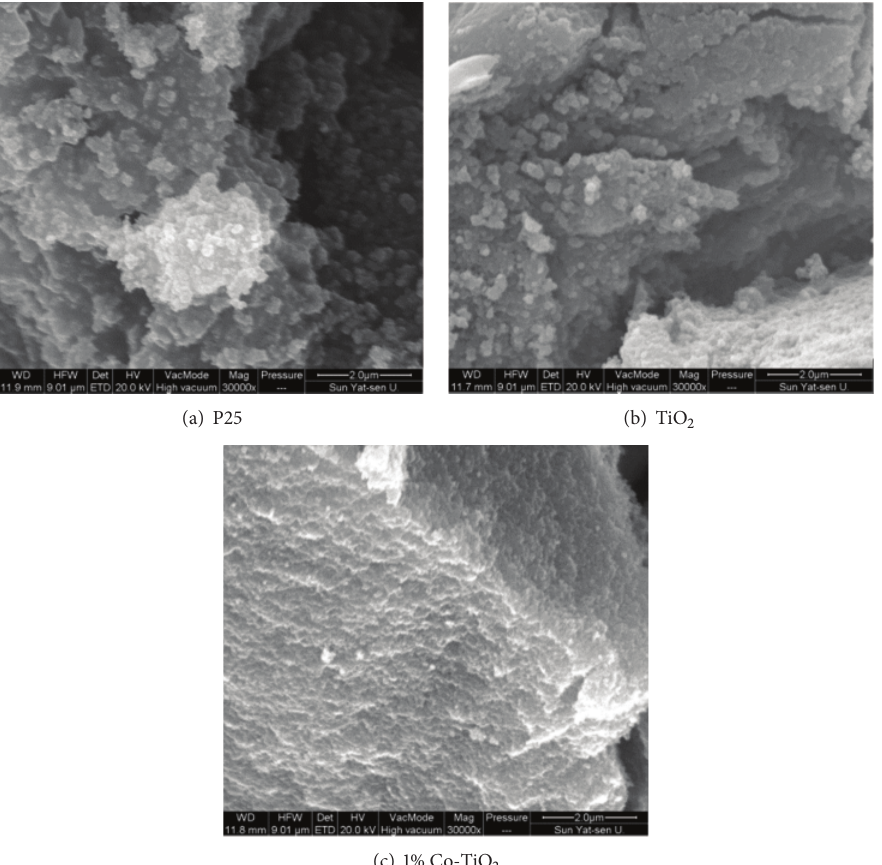
Figure 3: SEM images of photocatalysts: (a) P25, (b) TiO 2 , and (c) 1% Co-TiO 2 .